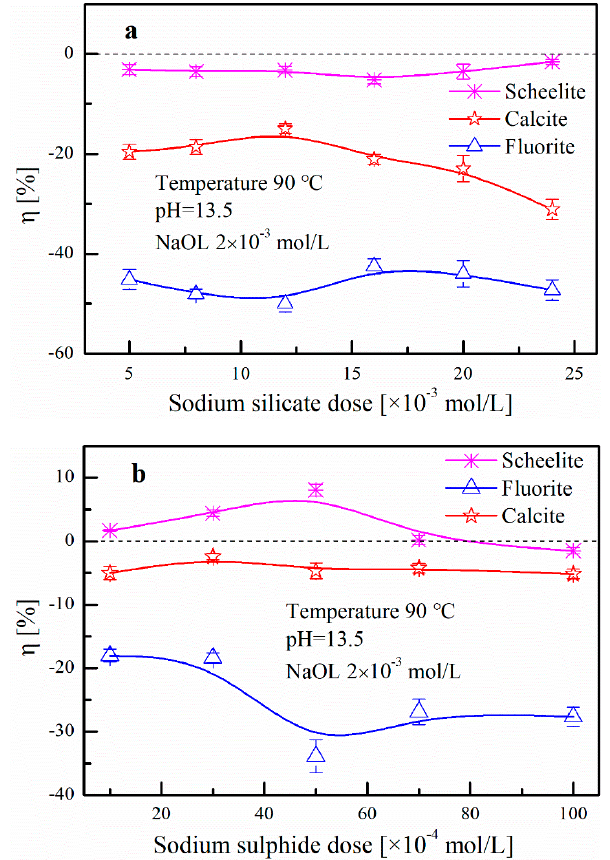
Figure 6. Changes in the adsorption amount of NaOL on the minerals surfaces at different Na 2 SiO 4 ( a ) and Na 2 S ( b ) doses compared with those without Na 2 SiO 4 or Na 2